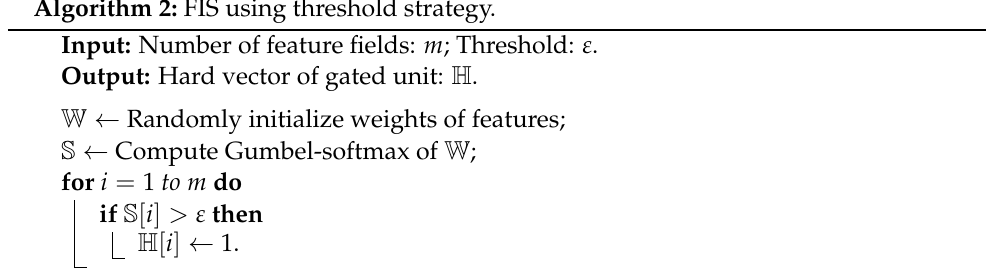
Algorithm 2: FIS using threshold